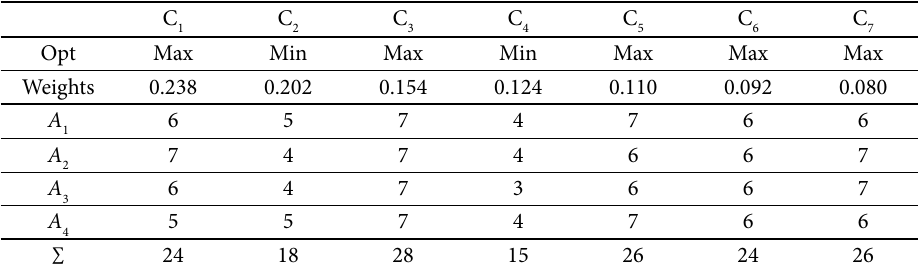
Table 4. Initial decision-making matrix with values of the attributes describing the compared alternatives (COPRAS)